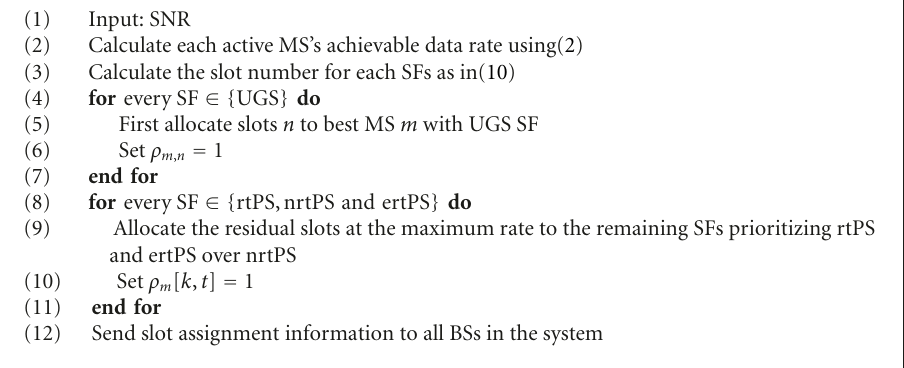
Algorithm 1: Resource allocation at RNC.